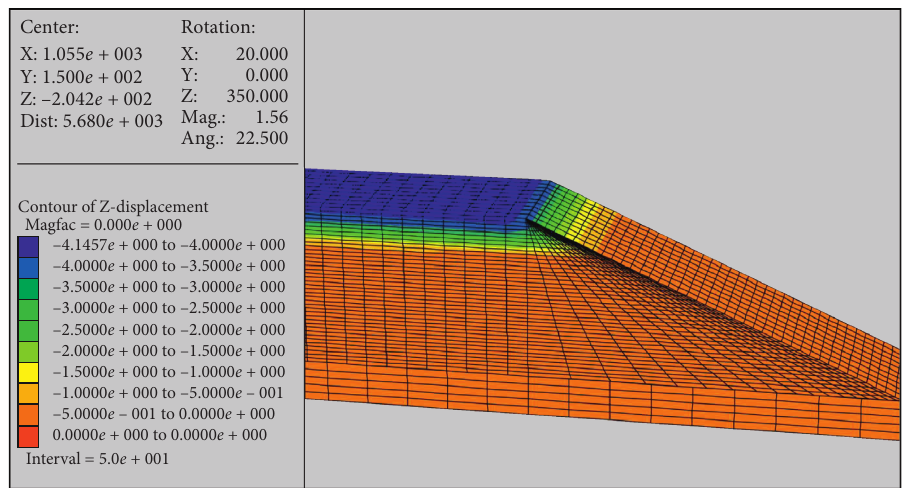
Figure 10: Vertical displacement of a slope after conventional excavation.